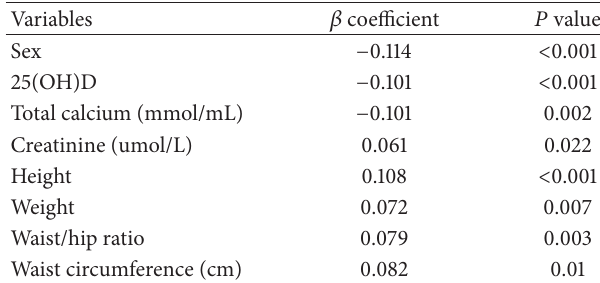
— — Table 5: Multiple factor logistic regression of high serum PTH of greater than normal